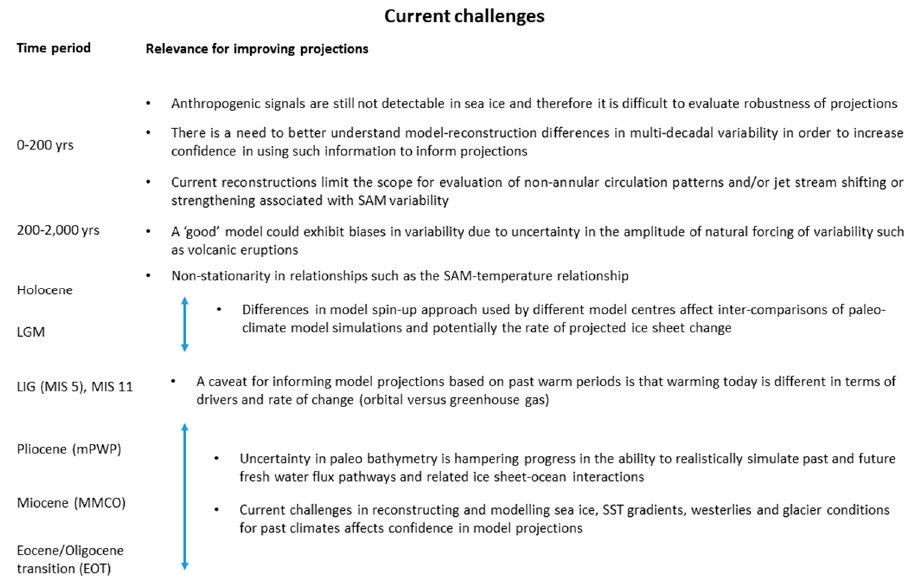
Figure 3. As Figure 2, but from the sections on ‘current challenges’.